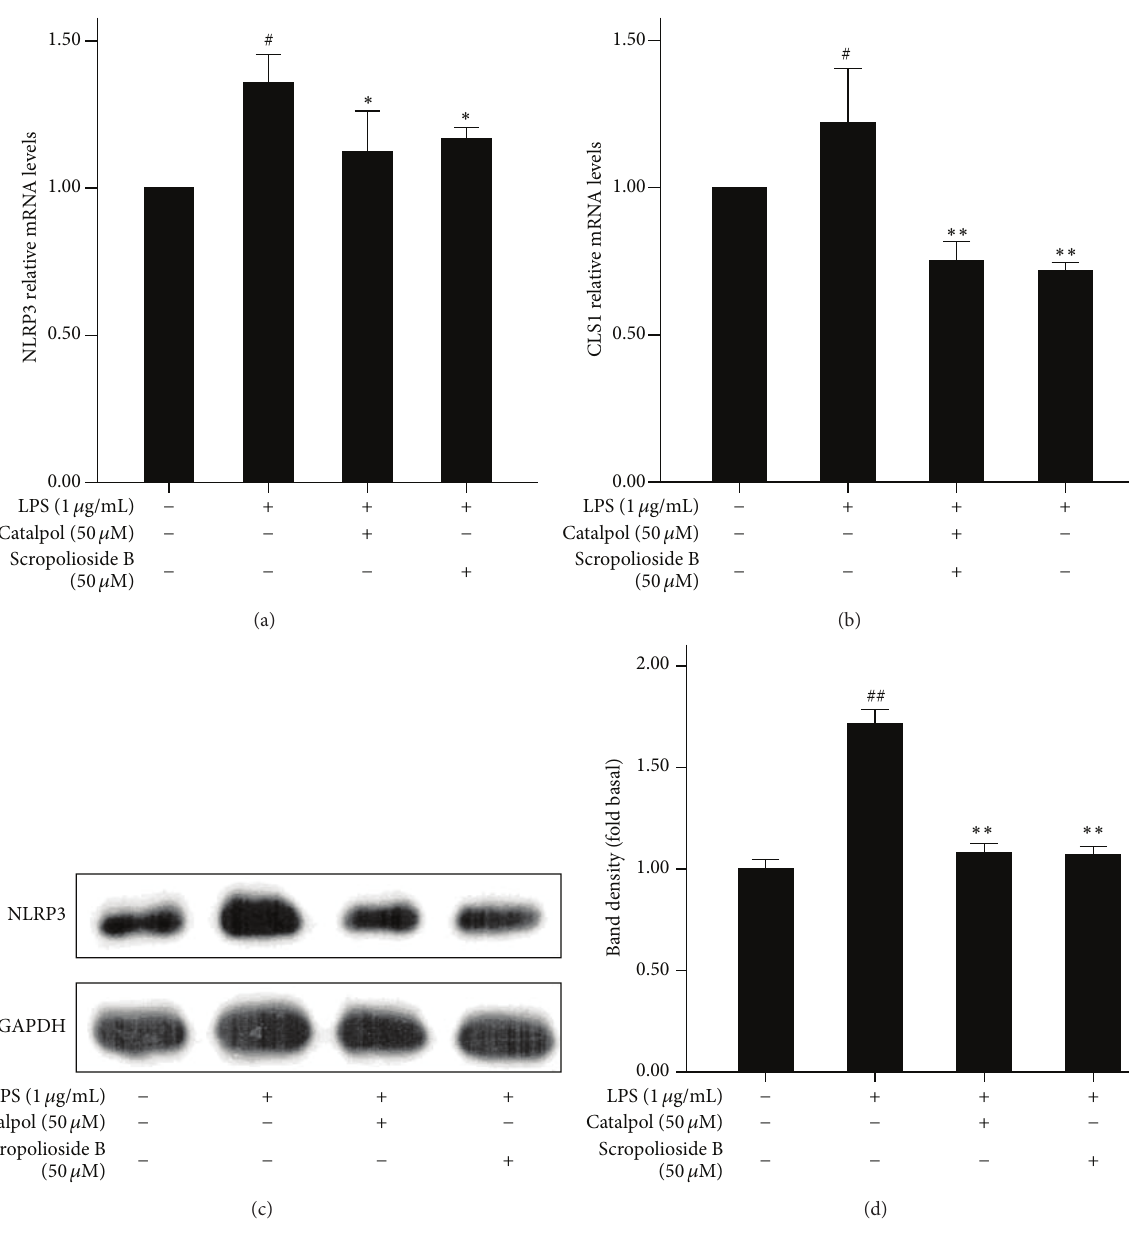
Figure 4: Scropolioside B and catalpol inhibited the expression of CLS1 and NLRP3 in LPS-induced THP-1 cells. ((a)-(b)) The effects of scropoliosideBandcatalpolonproteinexpressionofNLRP3inLPS-inducedTHP-1cells.((c)-(d))THP-1cellswerepretreatedwith50 𝜇 mol/L catalpol or scropolioside B for 1h and then stimulated with LPS (1 𝜇 g/mL) for another 24 h. The protein expression of NLRP3 was measured by western blot. The expression of CLS1 and NLRP3 mRNA was measured by RT-PCR. The data represent the mean values of over three experiments ± SD. ## 𝑃 < 0.01 compared to vehicle control, # 𝑃 < 0.05 compared to vehicle control, and ∗∗ 𝑃 < 0.01 compared to LPS